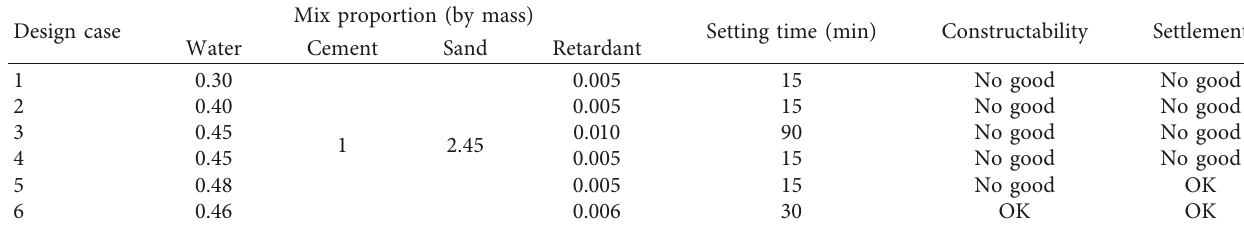
Table 5: Mix proportion and outcome of design considerations.